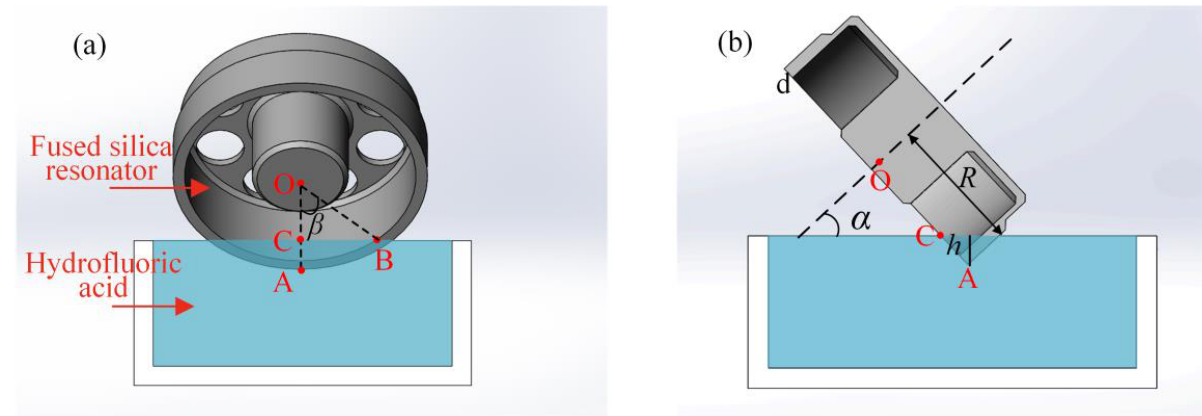
Figure 8. Schematic view of the chemical balancing: ( a ) The front view; ( b ) The half-section view. According to the multi-mode trimming theory [35–37], the second harmonic error could be balanced by removing mass from two positions starting from the heavy axis where the value of the second harmonic error reaches maximum. The mass element removed by chemical balancing from the two positions can be express as: